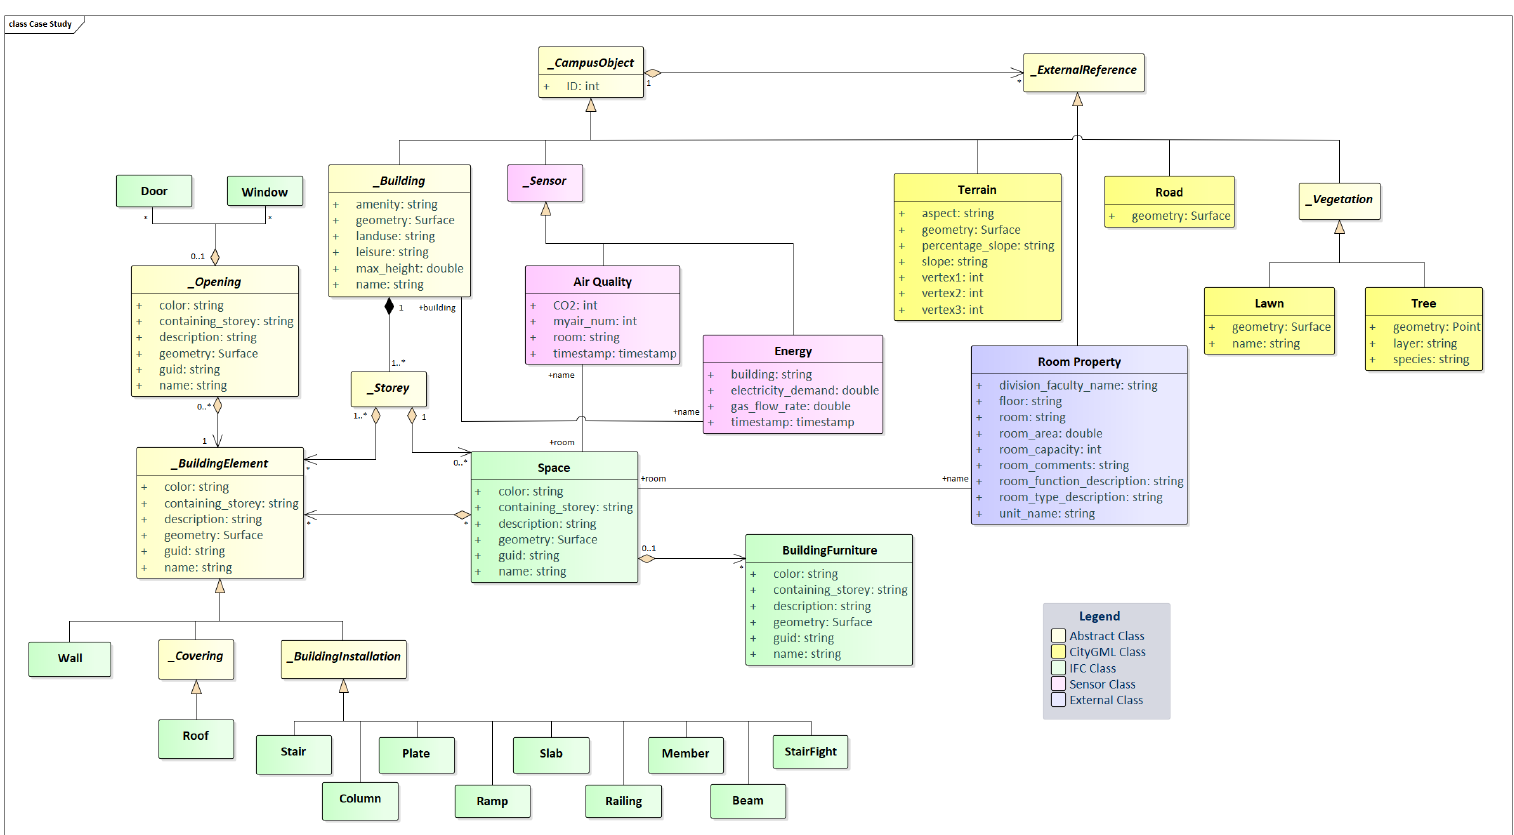
Figure 15. UML diagram for integrated UNSW campus